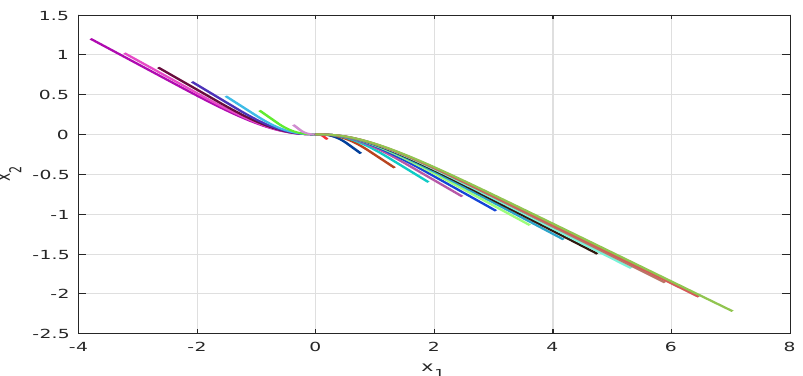
Figure 14. An illustration of the time responses between the real subspace pertaining to the model in (20), in which ˜ u ( t ) = 0 in Example